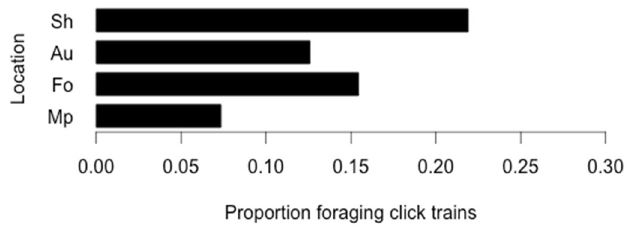
Figure 4. Summary of the proportion of trains classified as foraging for each location (Mp = Moneypoint, Fo = Foynes, Au = Aughinish and Sh = Shannon Airport).